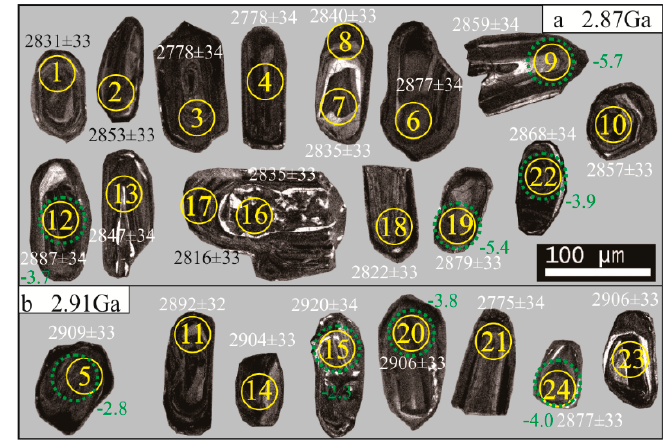
Figure 12. Representative cathodoluminescence images of zircons from the moyite dike (D0002-5). Symbols are as in Figure 4. ( a ) Magmatic zircons with crystallization age; ( b ) Inheritance of zircons with metamorphic age.